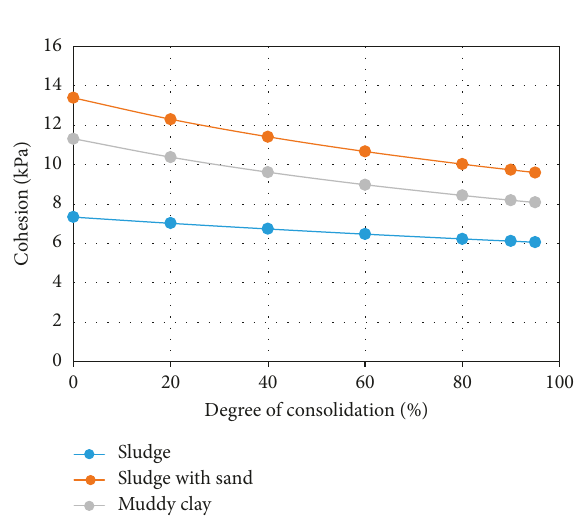
Figure 2: Relationship curve of cohesion and degree of